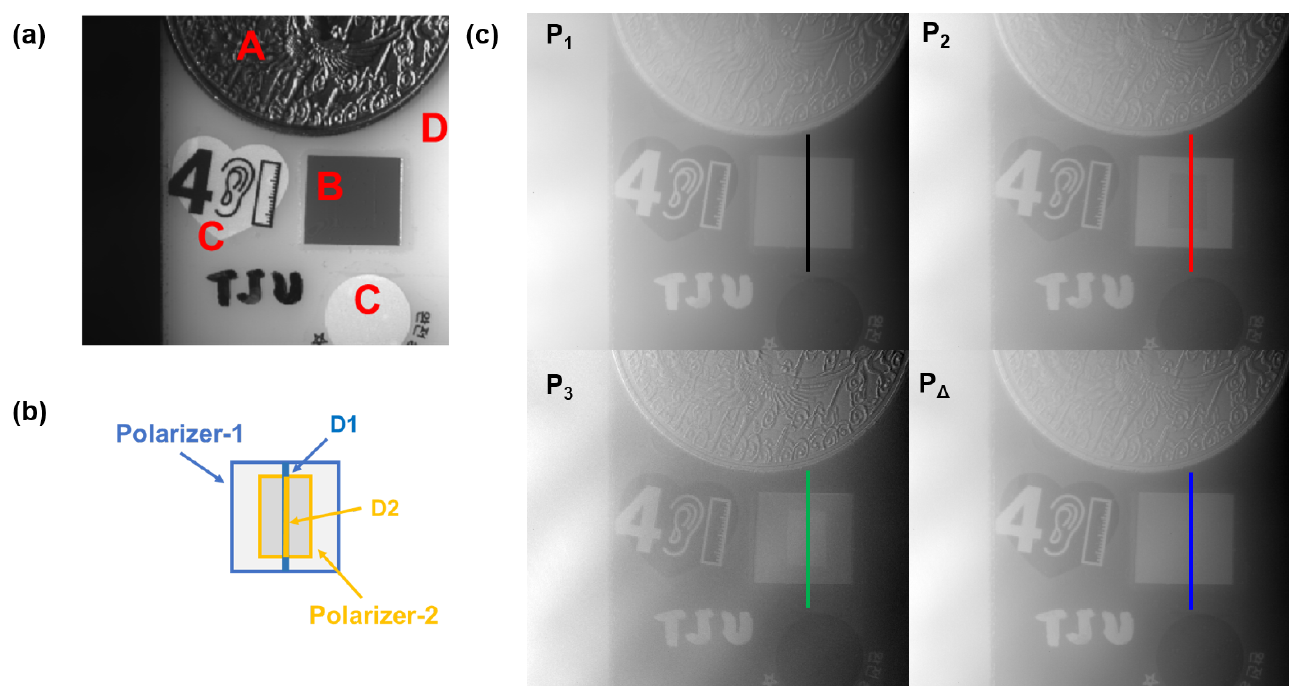
Figure 8. ( a ) Intensity image of a clear scene containing a metal coin (A), two stacked film polarizers (B), paper tags (C) on a plastic baseboard (D). ( b ) Diagram of the two polarizers’ positions. ( c ) Images of the metrics: IPPs and P ∆